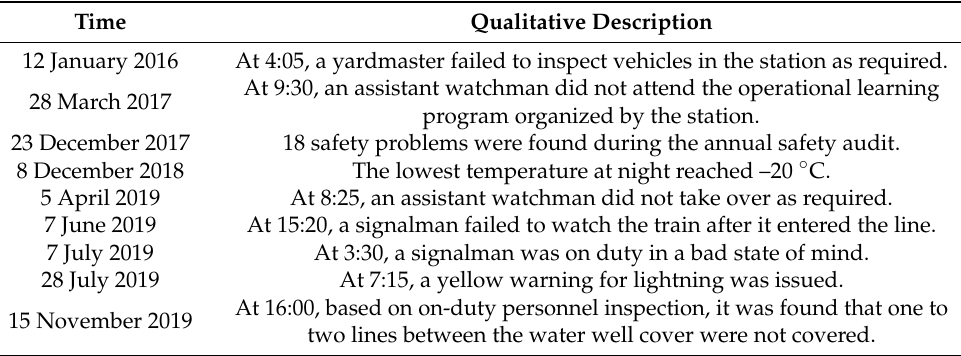
Table 8. Hazard factor data of the Huangyangcheng station in Shenshuo Railway (part). Time